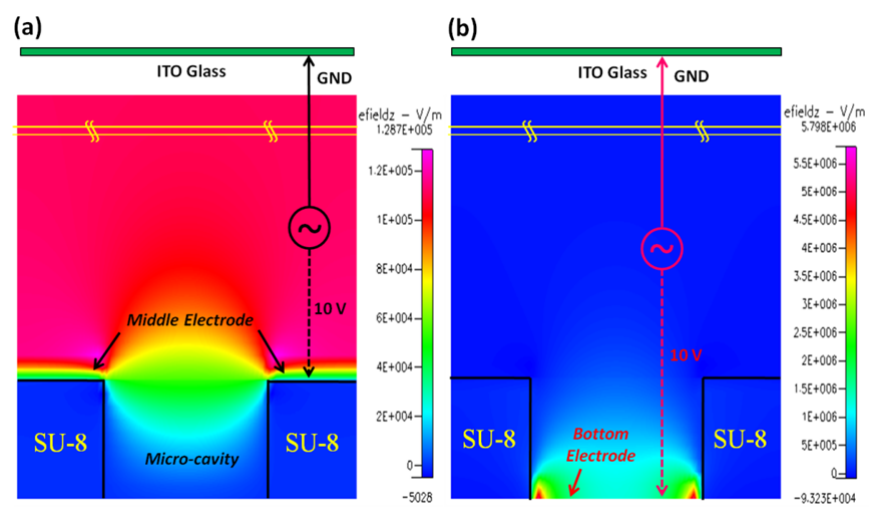
Figure 2. (a) The contour of electric field as applied the AC signal to the middle and top electrodes for trapping cells; (b) The contour of electric field as applied the AC signal to the bottom and top electrodes for releasing